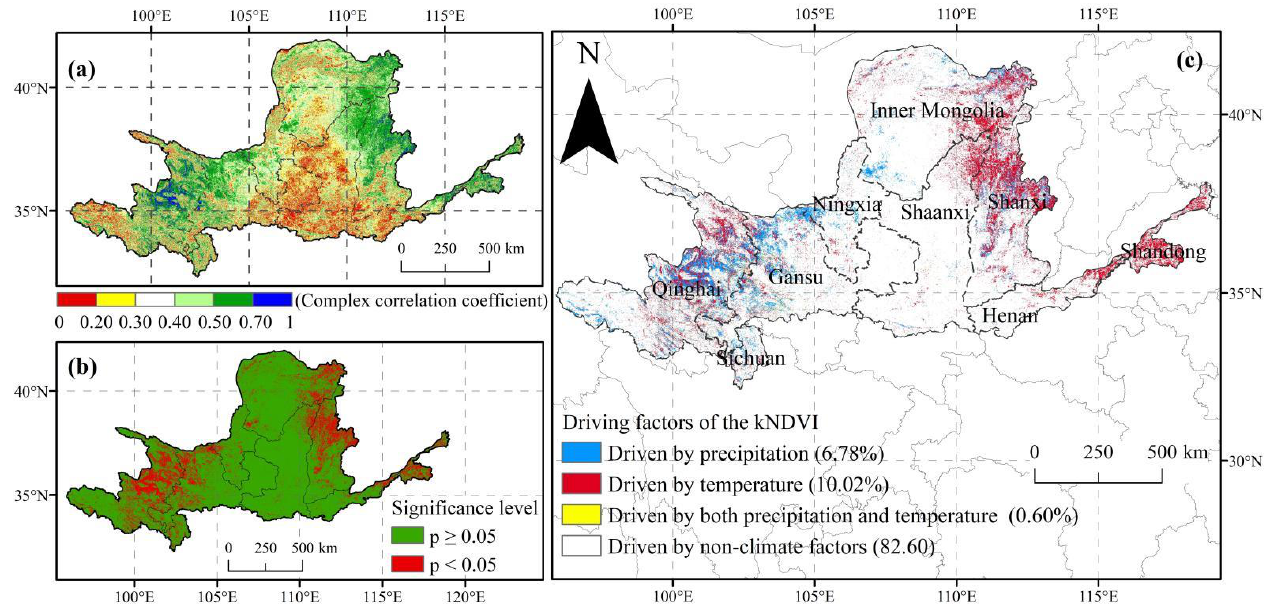
Figure 9. Analysis of driving factors of kNDVI: ( a ) spatial pattern of complex correlation coefficient between kNDVI and climate factors, ( b ) significance level of the complex correlation coefficient, and ( c ) driving factors of the kNDVI in the YRB from 2001 to 2020.